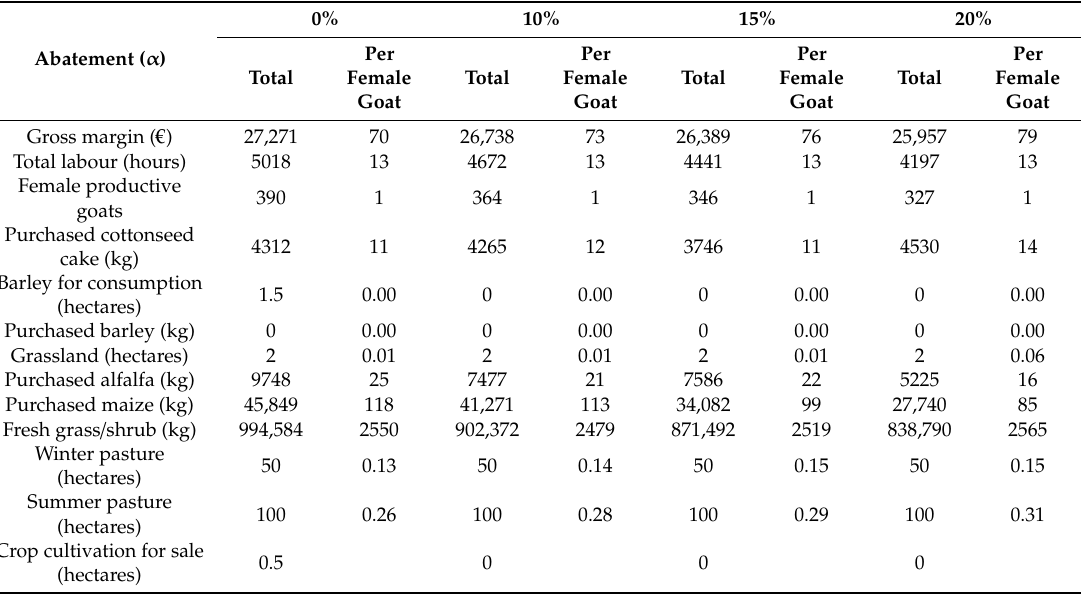
Table 9. Optimal farm plan of the extensive farm.